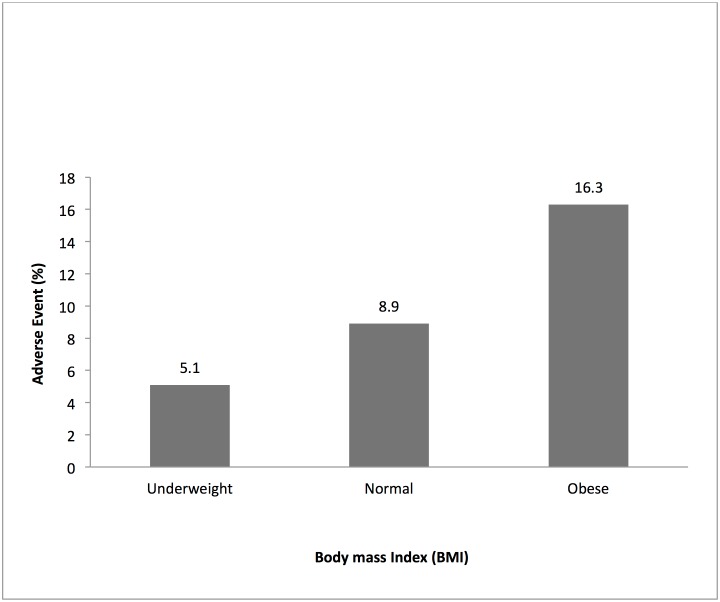
The relationship between the incidence of adverse events and body mass index as characterized as underweight, normal and obese among the study participants who were eighteen years of age and above.